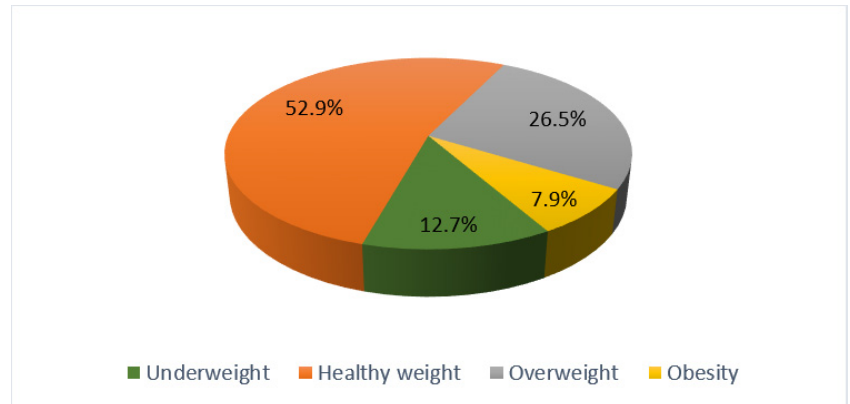
Figure 1. Distribution of students by body mass index (BMI).